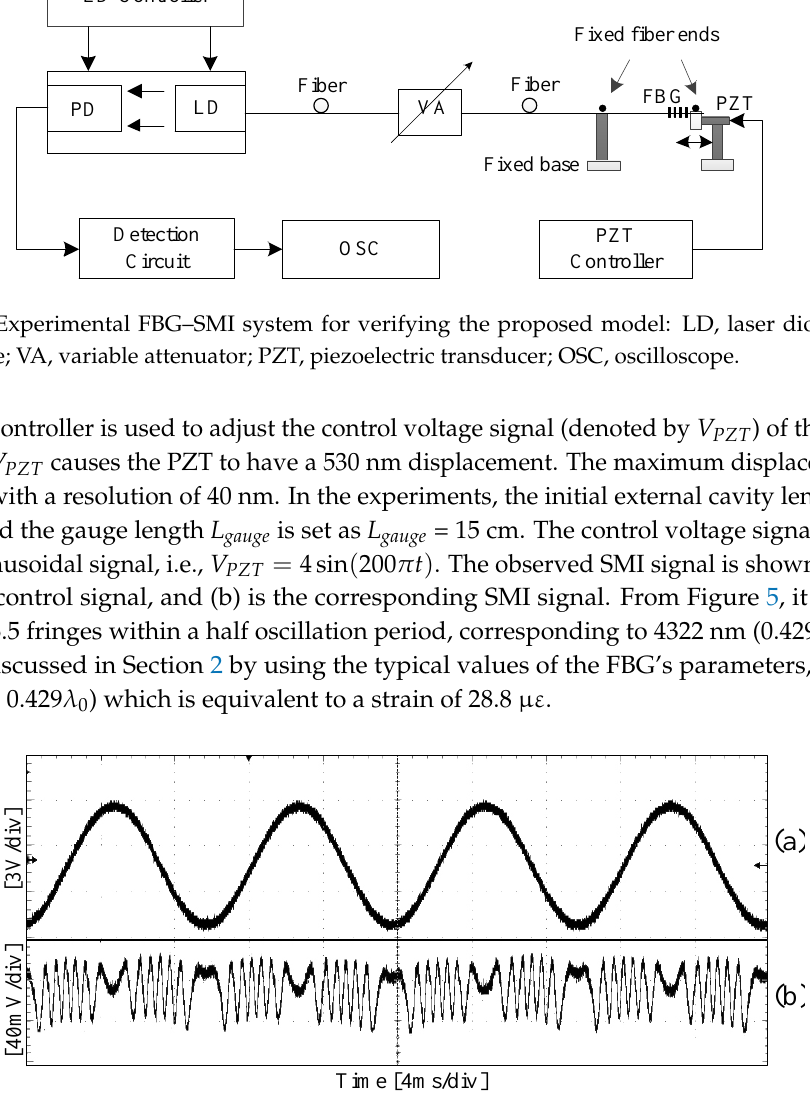
Figure 5. SMI signal of the FBG–SMI system when L 0 = 3 m, I = 25 mA, ( a ) Control voltage applied on PZT, ( b ) SMI signal.